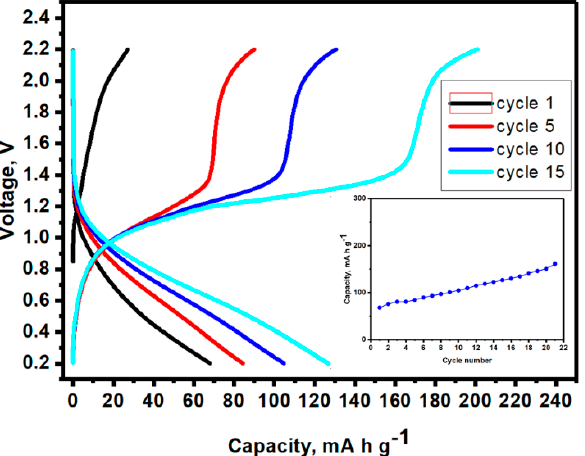
Figure 7. Galvanostatic charge-discharge plot at 20 mA g − 1 of a nano-Sn/MgMn 2 O 4 full cell, using 0.5 M Mg(ClO 4 ) 2 in AN electrolyte and m + /m − = 4:1. Inset: Capacity vs. cycle number.